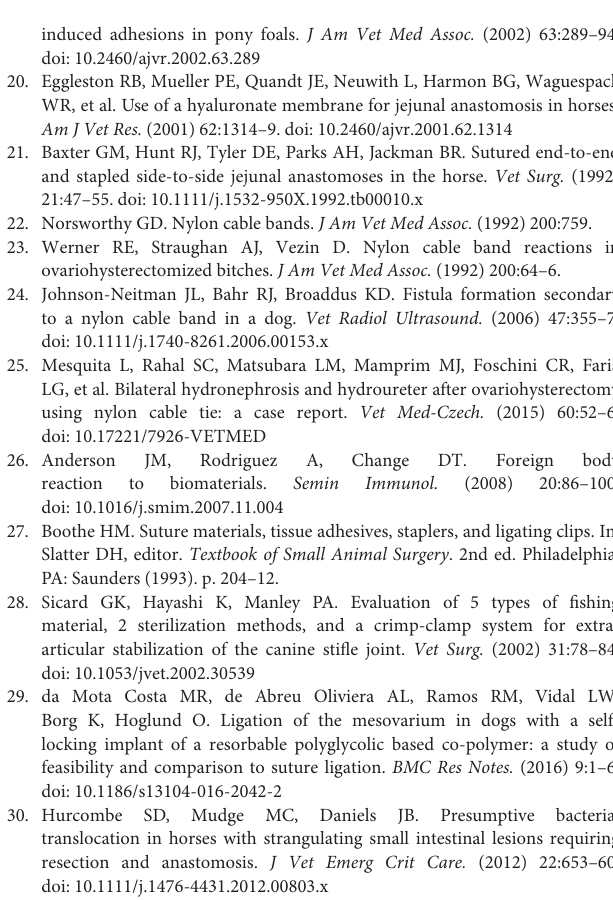
Supplementary File 1 | Creating mesenteric fenestrations for NCT placement. Supplementary File 2 | Placement of two NCT around the jejunal vasculature.